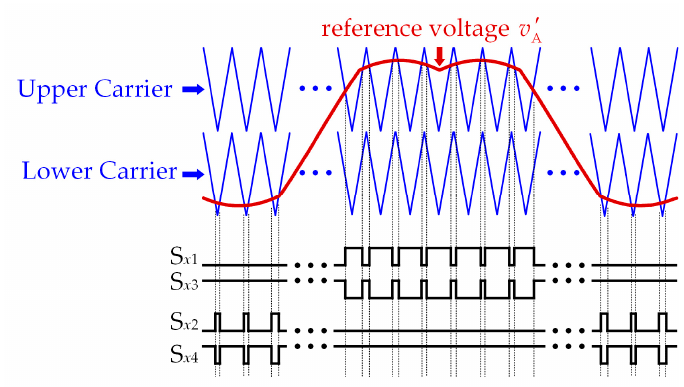
Figure 3. The reference voltage and the carriers of the conventional CBPWM.